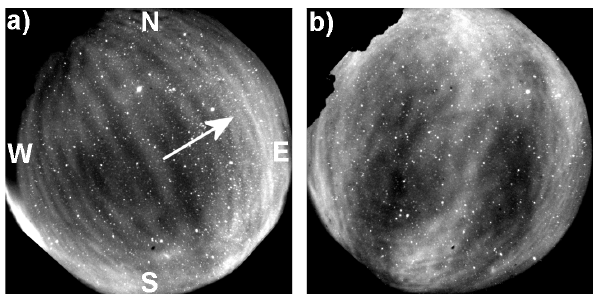
Fig. 2. Two examples of all-sky images showing short and medium- scale gravity wave structures in the mesospheric OH emission. The data were obtained from Brasilia on two consecutive nights (a)